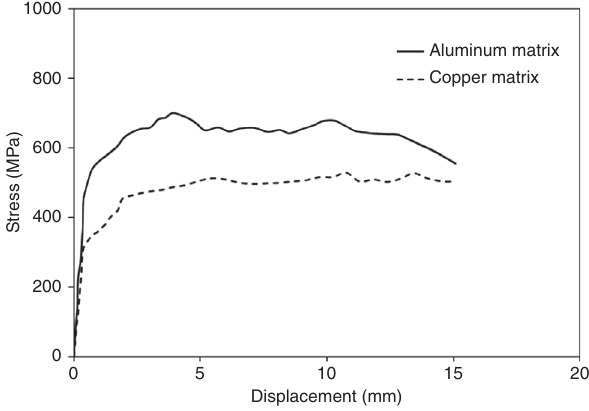
Figure 9 Pull-out load-deflection curves for pseudoelastic Ni-Ti (SMA) fibers from aluminum matrix at 35 °